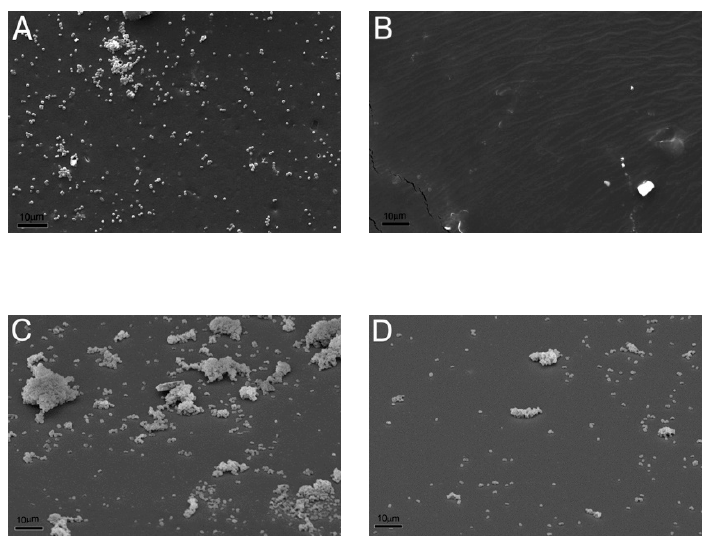
Figure 9. Initial bacterial adhesion after 30 min incubation on PEUA ( A ) and PEUA-PEG 30 ( B ). Biofilm formation after 24 h incubation on PEUA ( C ) and PEUA-PEG 30 ( D ). Scale bar = 10 µm.